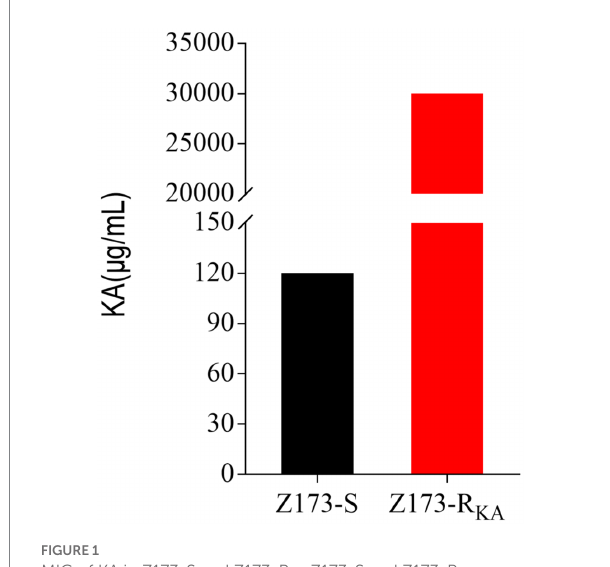
FIGURE 1 MIC of KA in Z173-S and Z173-R KA . Z173-S and Z173-R KA were incubated with PSA broth containing different concentrations of KA in 24-well plates at 30 ° C for 18 h. Results are displayed as mean ± SD. At least three biological repeats were carried